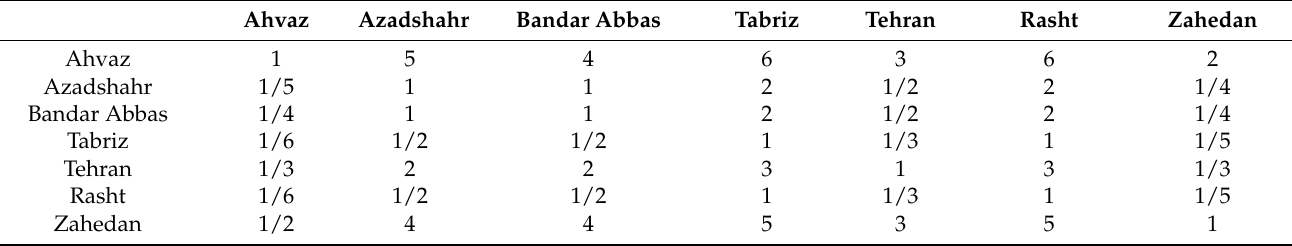
Table 5. Pairwise comparison matrix of alternatives with respect to